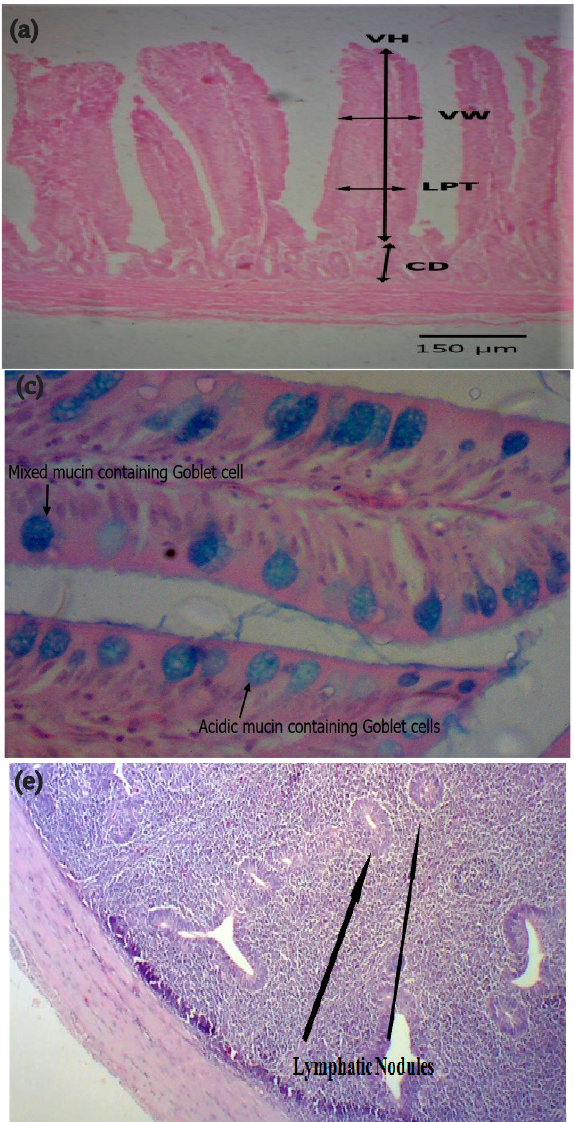
Figure 3. ( a ) Villi of the small intestine stained with H&E stain at 4x; VH means villus height, VW means villus width, LPT means lamina propria thickness, CD means crypt depth. ( b ) Intraepithelial lymphocytes in the villi stained with H&E at 40x. ( c ) Acidic and mixed goblet cells in the villi stained with combined alcian blue ‐ periodic acid Schiff stain at 40x. ( d ) Bursa of fabricius follicles stained with H&E stain at 4x. ( e ) Cecal tonsil nodules stained with H&E at 10x.